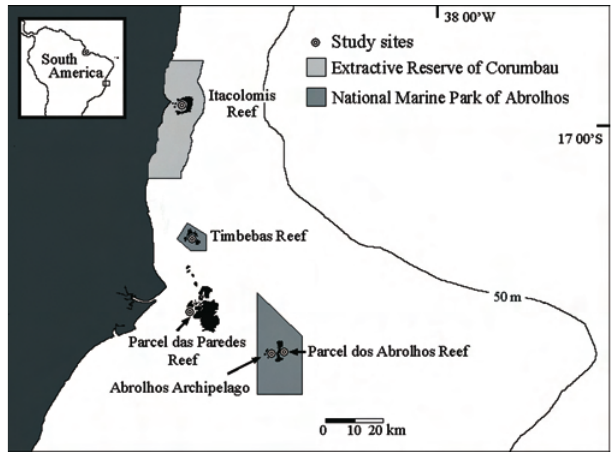
Fig. 1. Map of the Abrolhos Bank, showing study